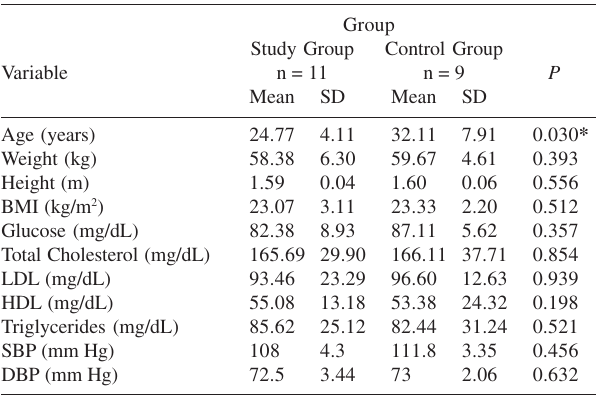
Table 1 - Clinical and laboratory data of study and